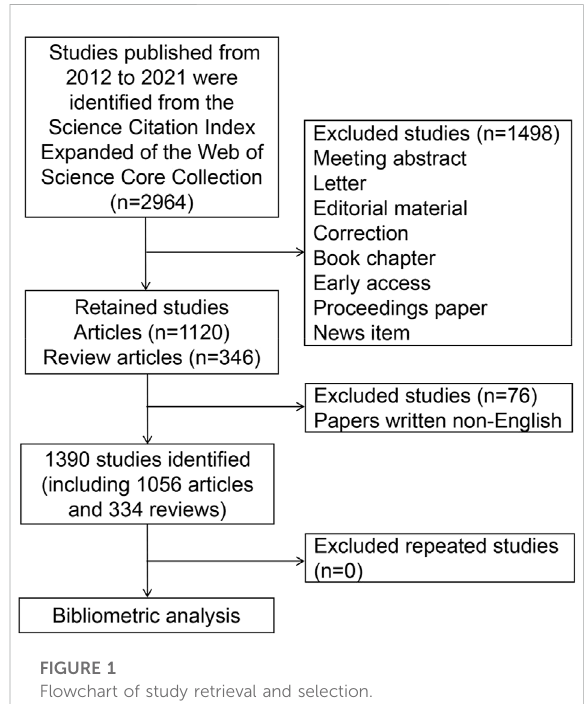
FIGURE 1 Flowchart of study retrieval and